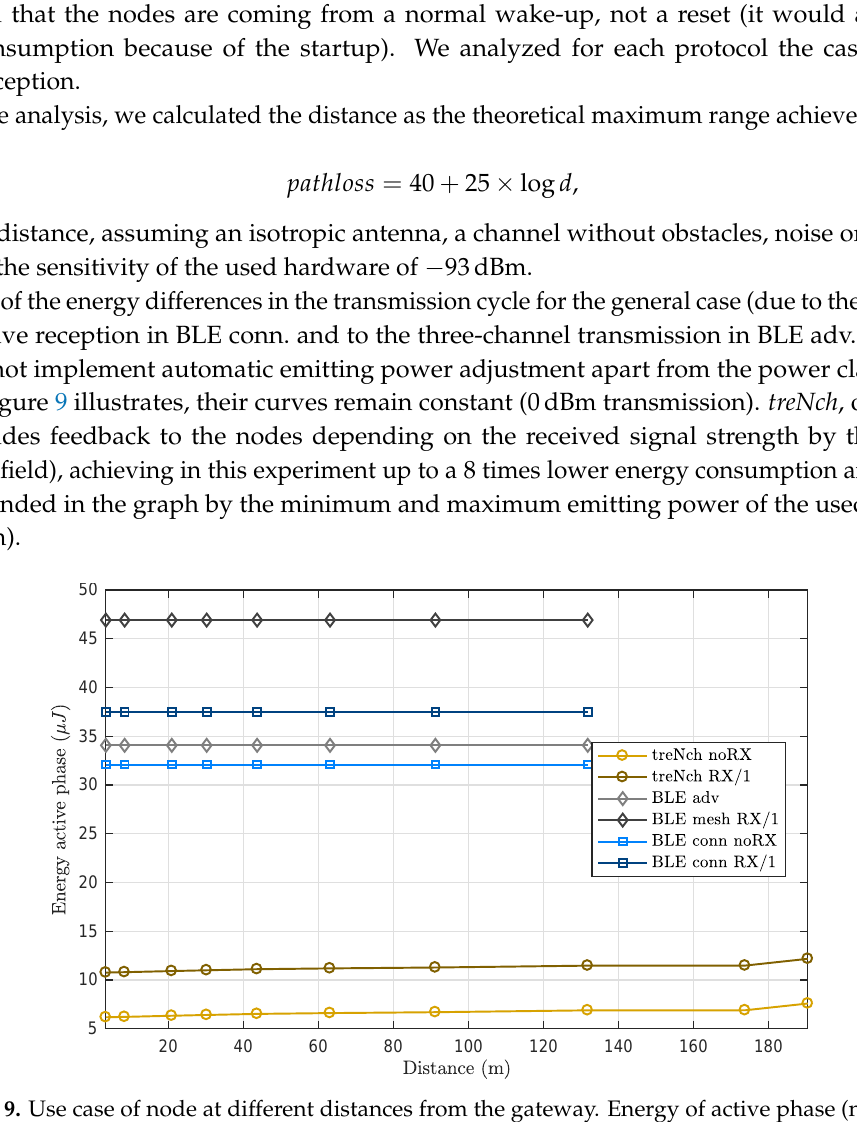
Figure 9. Use case of node at different distances from the gateway. Energy of active phase (no sleep time considered) over distance. Notice that BLE remains